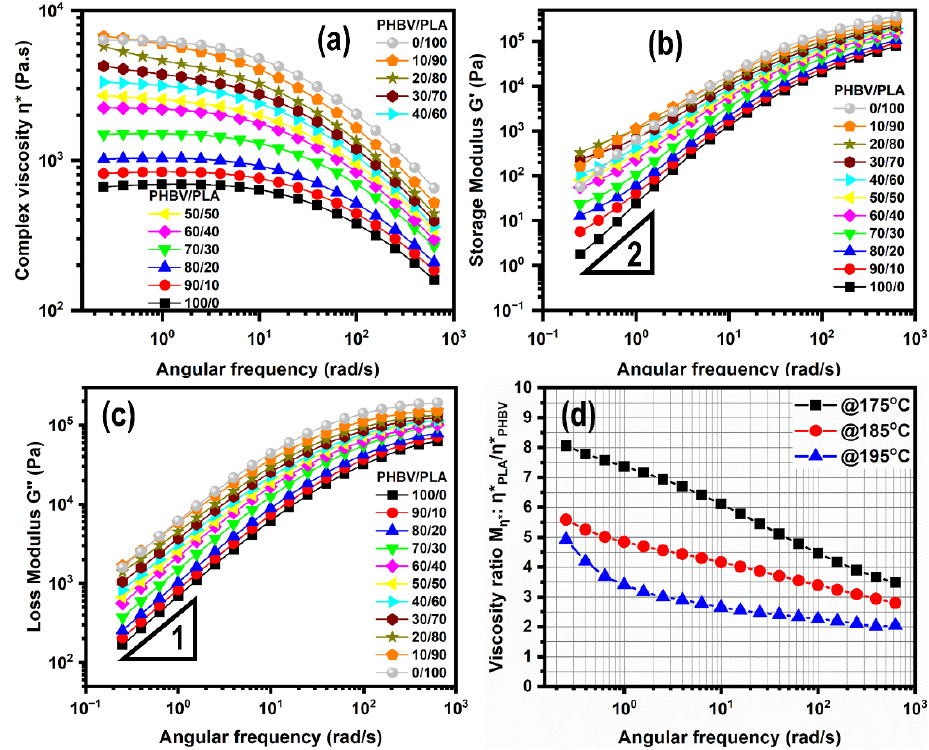
Figure 10. Example of results at 175 ◦ C with ( a ) complex viscosity modulus η ∗ , ( b ) storage modulus G (cid:48) , ( c ) loss modulus G (cid:48)(cid:48) , and ( d ) viscosity ratio M η ∗ for neat PLA, PHBV, and their blends with var- ious compositions.